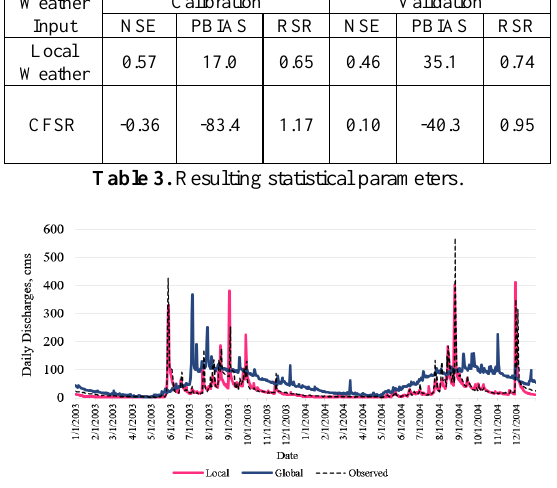
Figure 11. Discharge hydrographs after calibration.